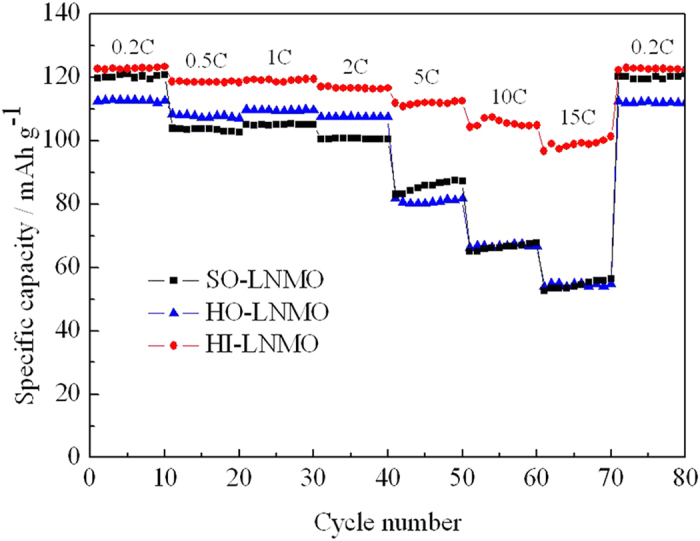
Rate capability of LiNi0.5Mn1.5O4 with different microstructures.